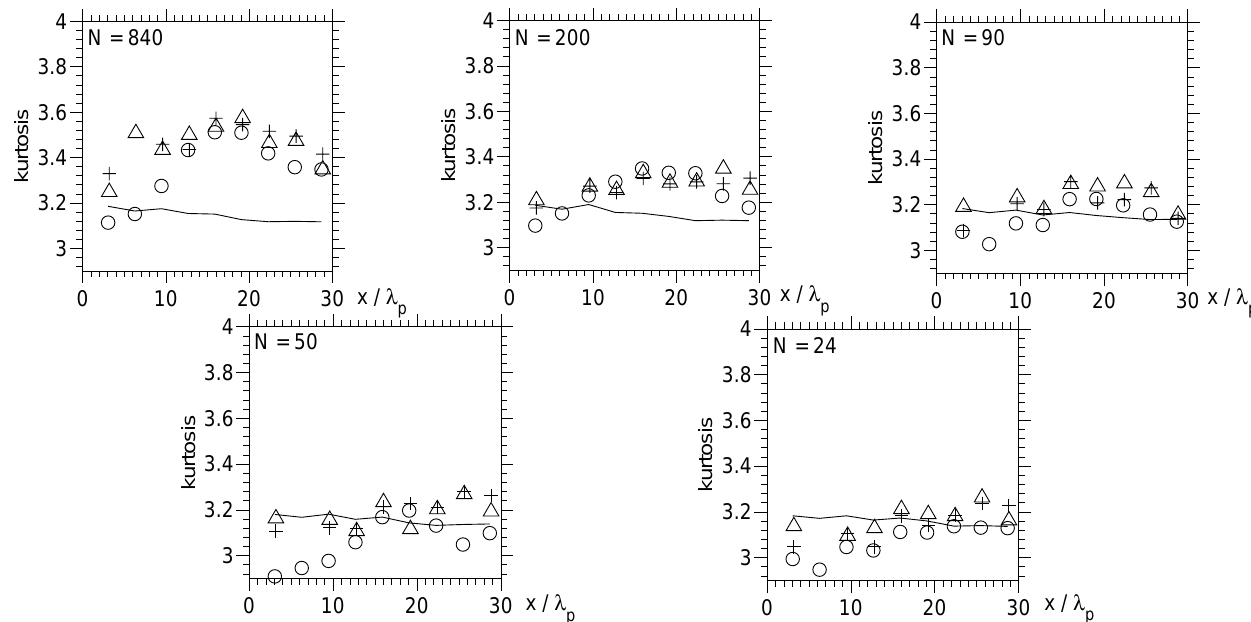
Fig. 6. Spatial evolution of the kurtosis: without current ( ◦ ); with current at 110deg (+); with current at 120deg ( 4 ); estimate based on second-order theory (continuous line).